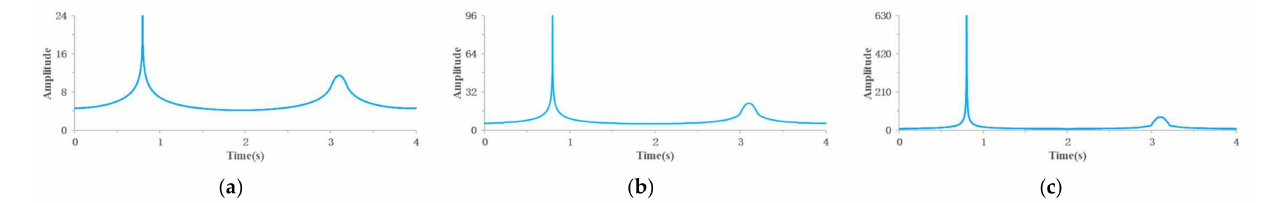
Figure 2. Instantaneous amplitudes of the synthetic 1D channel data in Figure 1a, which are obtained by LTFS with: ( a ) p =1.0, f 1 = 0 Hz and f 2 = f N = 500 Hz; ( b ) p = 0.8, f 1 = 0 Hz and f 2 = f N = 500 Hz; ( c ) p = 0.6, f 1 = 0 Hz and f 2 = f N = 500